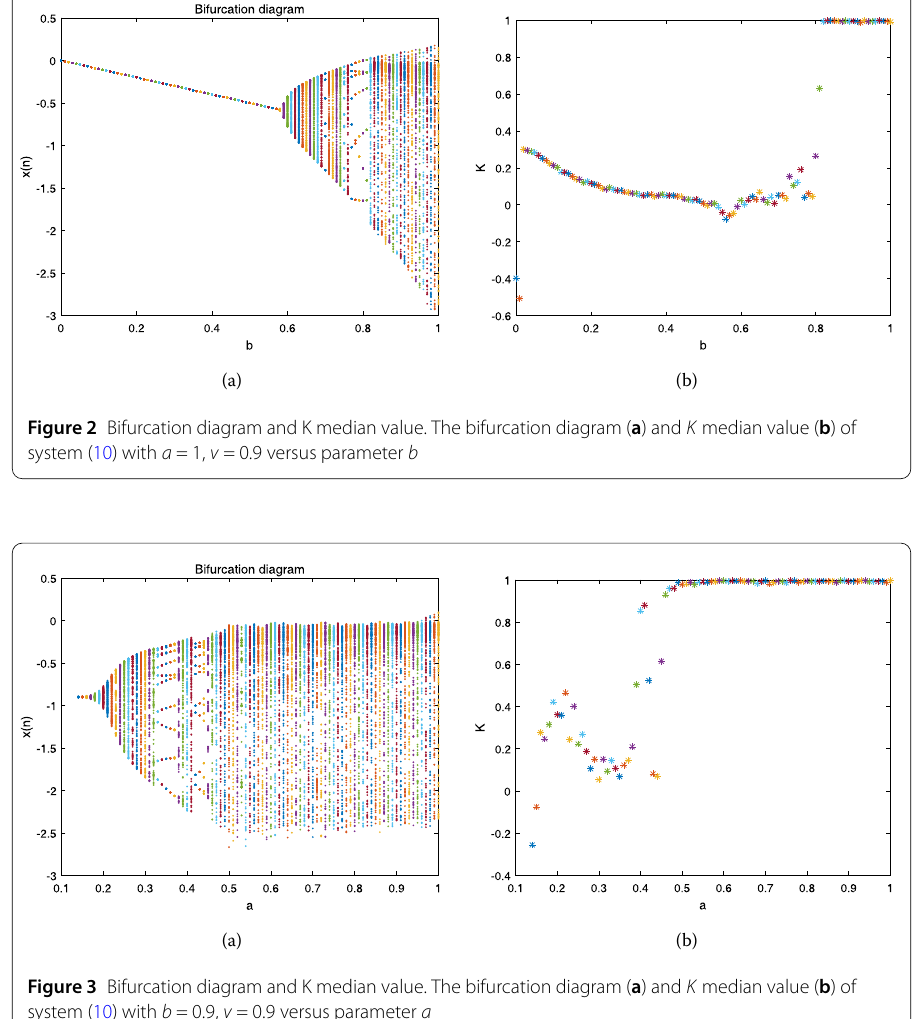
value of the time series x ( n ) of system (10) versus a ∈ [0,1] is drawn in Fig. 3(b). Then, let a = 1, b = 1, and the fractional over v is fixed. The step size of the v is set at 0.01, we